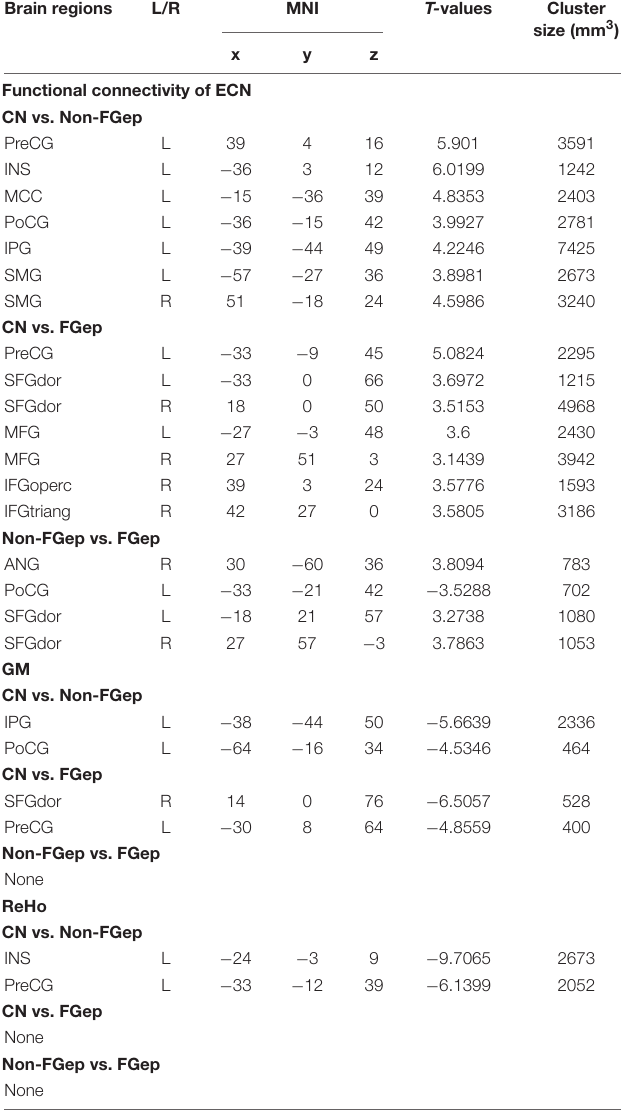
TABLE 2 | Comparison of GM, ReHo, and FC of ECN between CN, non-FGep, and FGep subjects. Brain regions